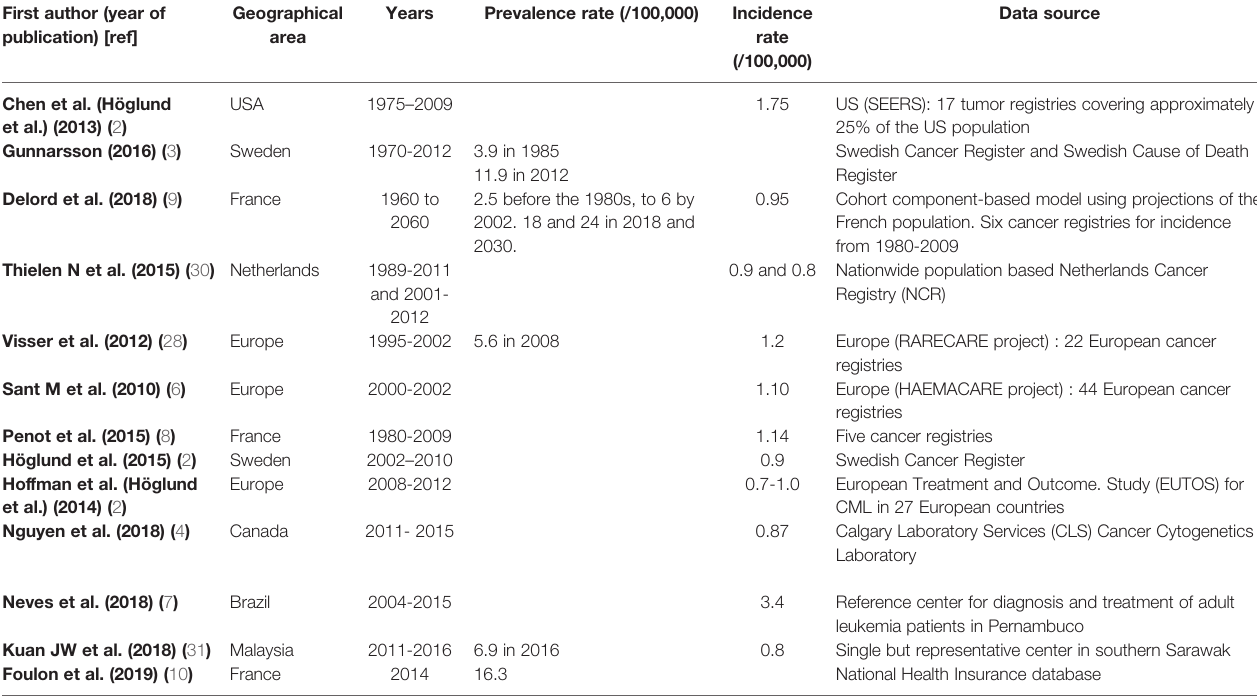
TABLE 4 | Chronic Myeloid Leukemia incidence and prevalence rates estimated from different population-based registries or